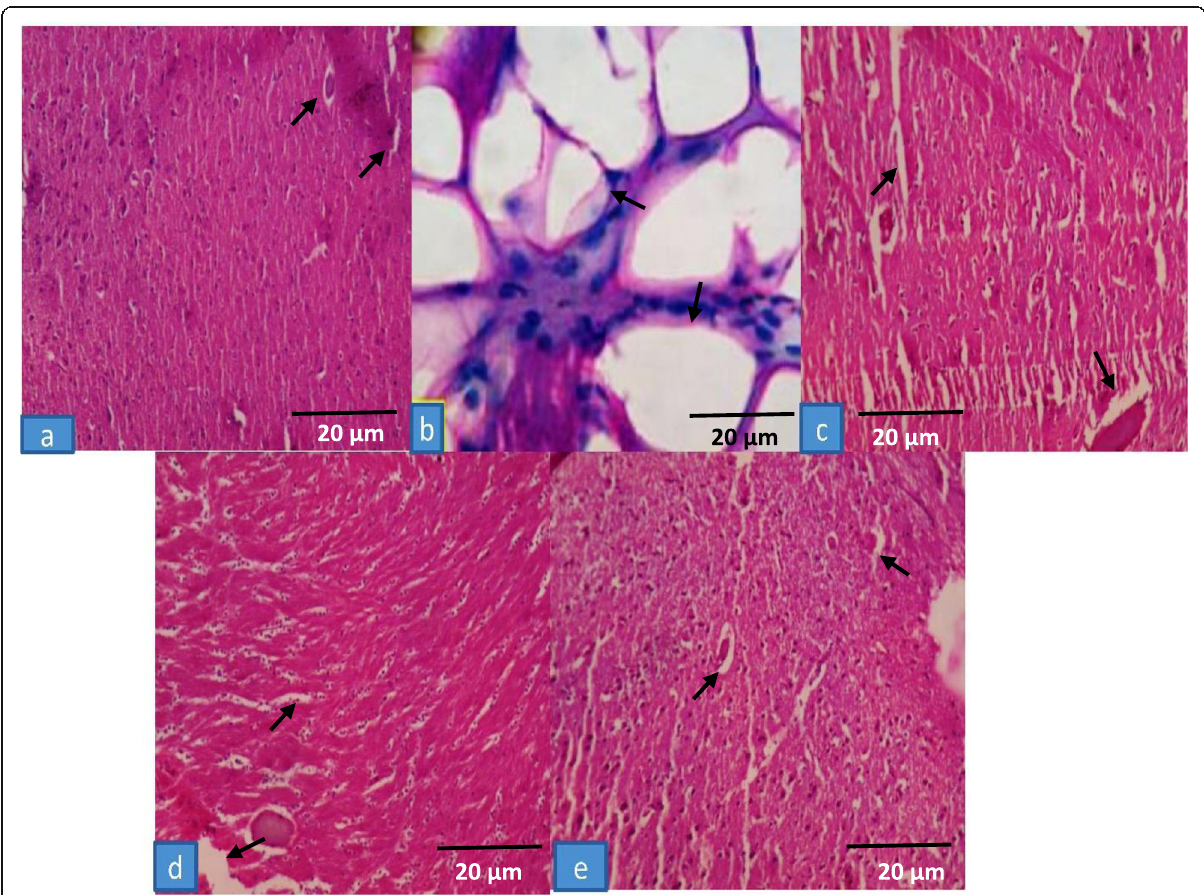
Fig. 8 Histopathology of brain sections from different treatment groups stained with hematoxylin and eosin. ( a.) Sham control (Sham) (b.) Ischemic Reperfusion group (I/R) (c.) ( Ricinus communis Low dose) (RCLD) (d.) Ricinus communis High dose (RCHD) (e.) (Standard drug-treated group)